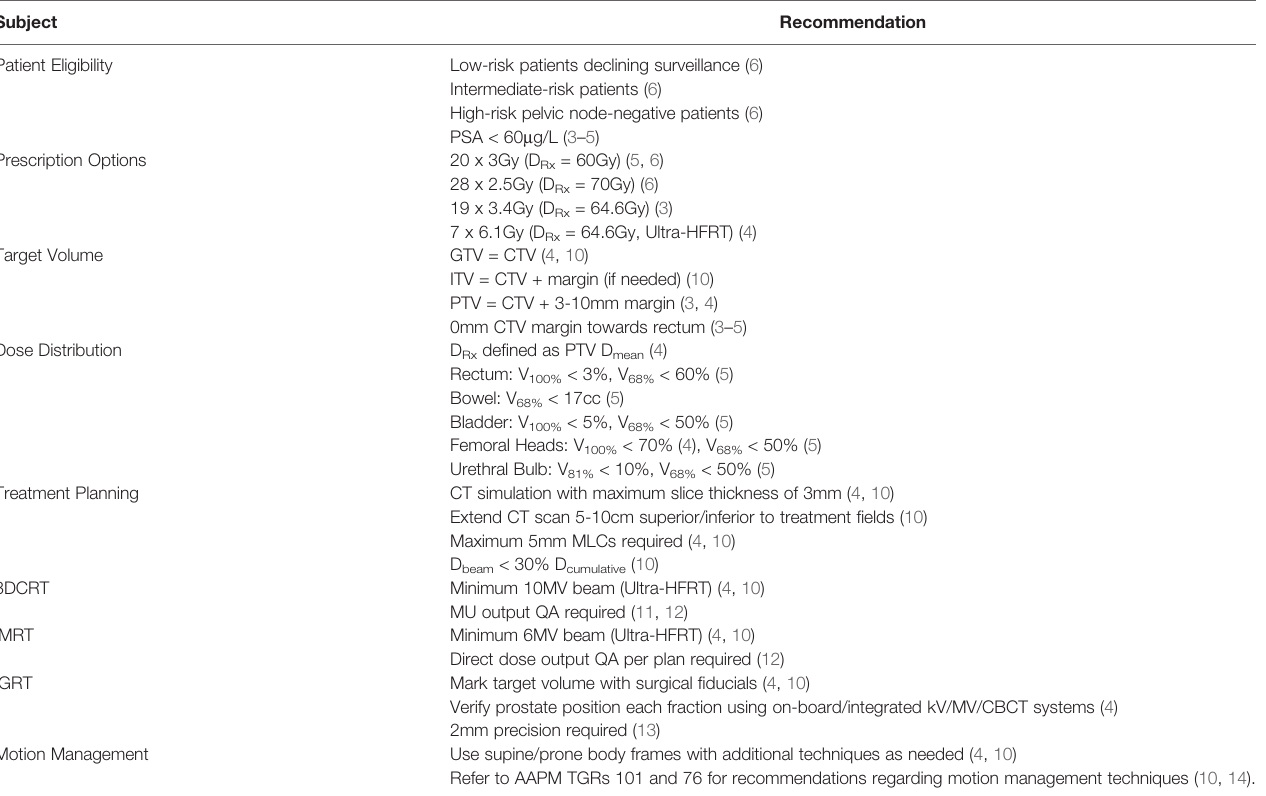
TABLE 1 | A summary of recommended prostate cancer HFRT treatment